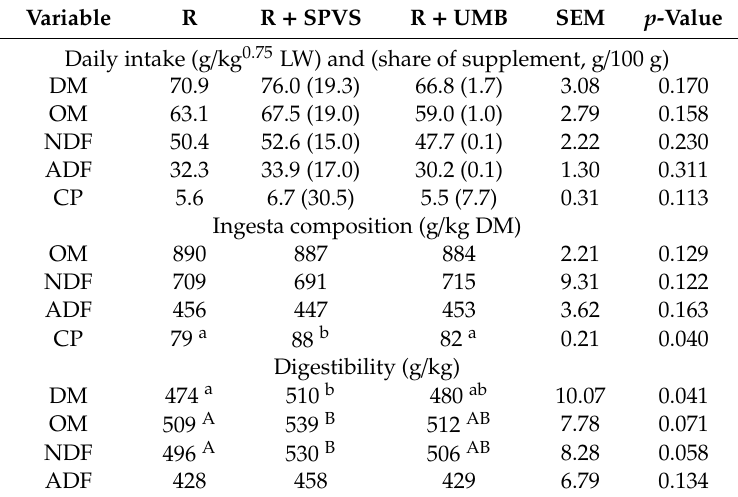
Table 2. Quantitative intake, ingesta composition, and digestibility of proximate nutrient and fiber fractions in heifers fed roughage (R) 1 alone or supplemented with sweet potato vine silage (R + SPVS) or urea-molasses blocks (R +